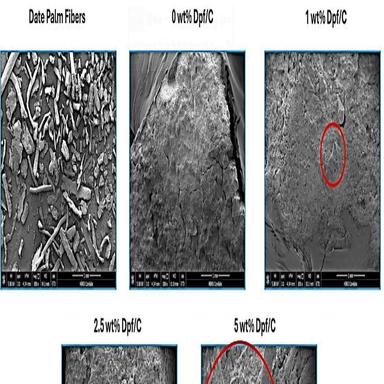
SEM images of different Dpf/C ratios and Dpf.